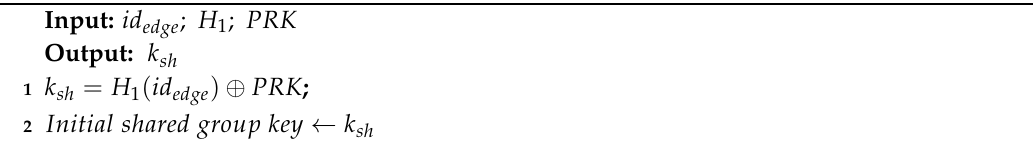
Algorithm 1: Edge algorithm for generating initial shared group key k sh